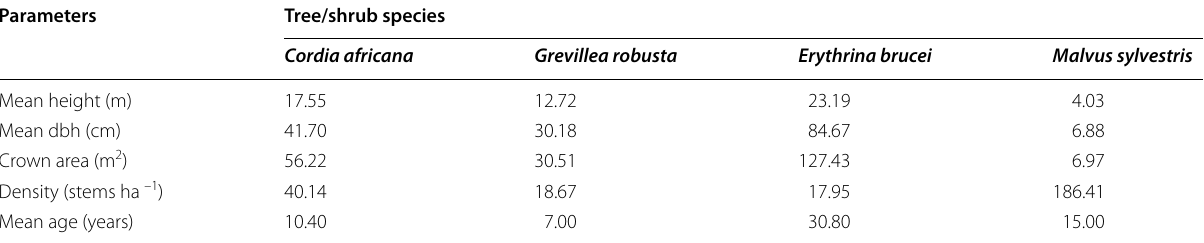
Table 2 Characteristics of tree/shrub species in the homegarden agroforestry systems of the study sites, southern and southwestern Ethiopia (n 20) =